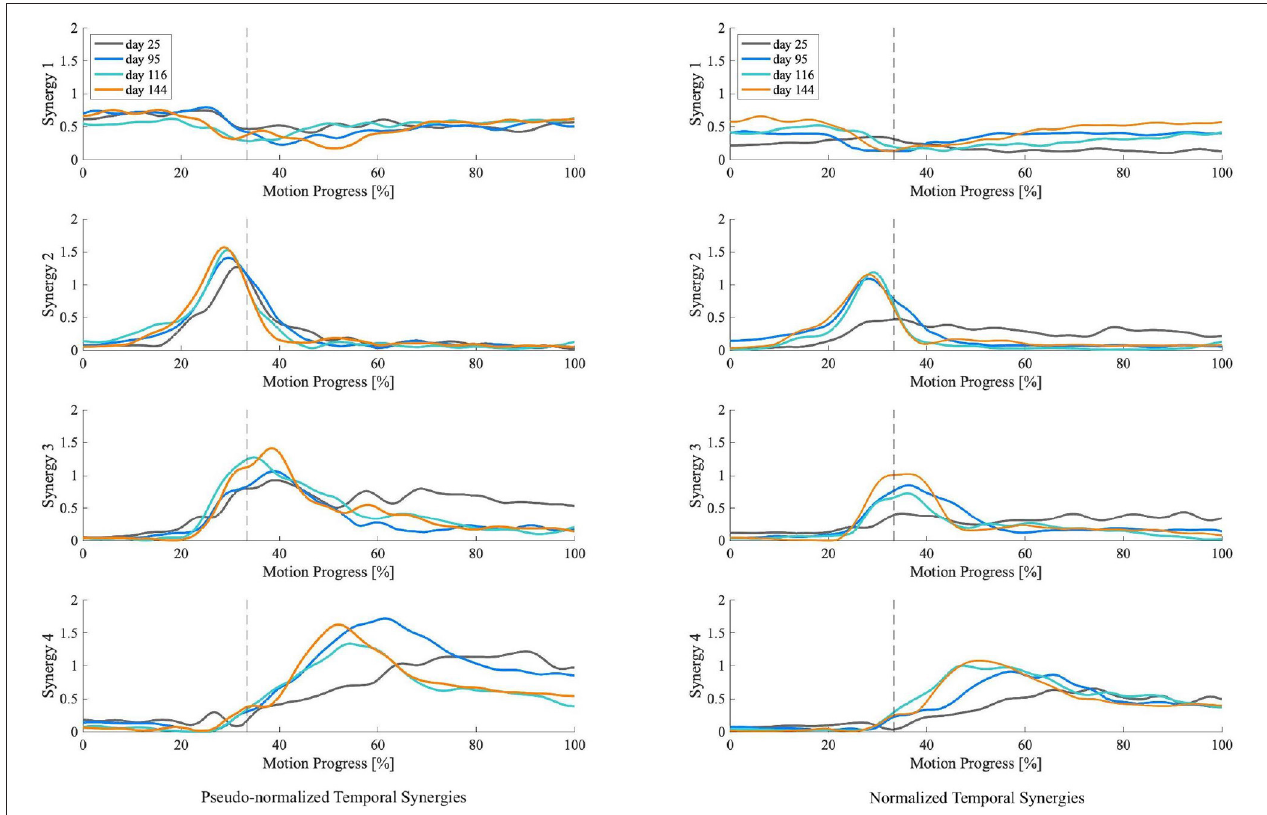
FIGURE 6 | Muscle synergy temporal patterns of the representative patient with +13 points of improvement in FMA score on the 25th, 95th, 116th, and 144th day after initial stroke onset. The left column shows temporal patterns of each synergy normalized by within-subject peak EMG, noted as pseudo-normalized for comparison. The right column shows temporal patterns of each synergy normalized by proposed method. Vertical axis indicates the weighting coefficients. Horizontal axis is STS motion progress expressed in percentage. Dotted vertical lines represent the seat-off